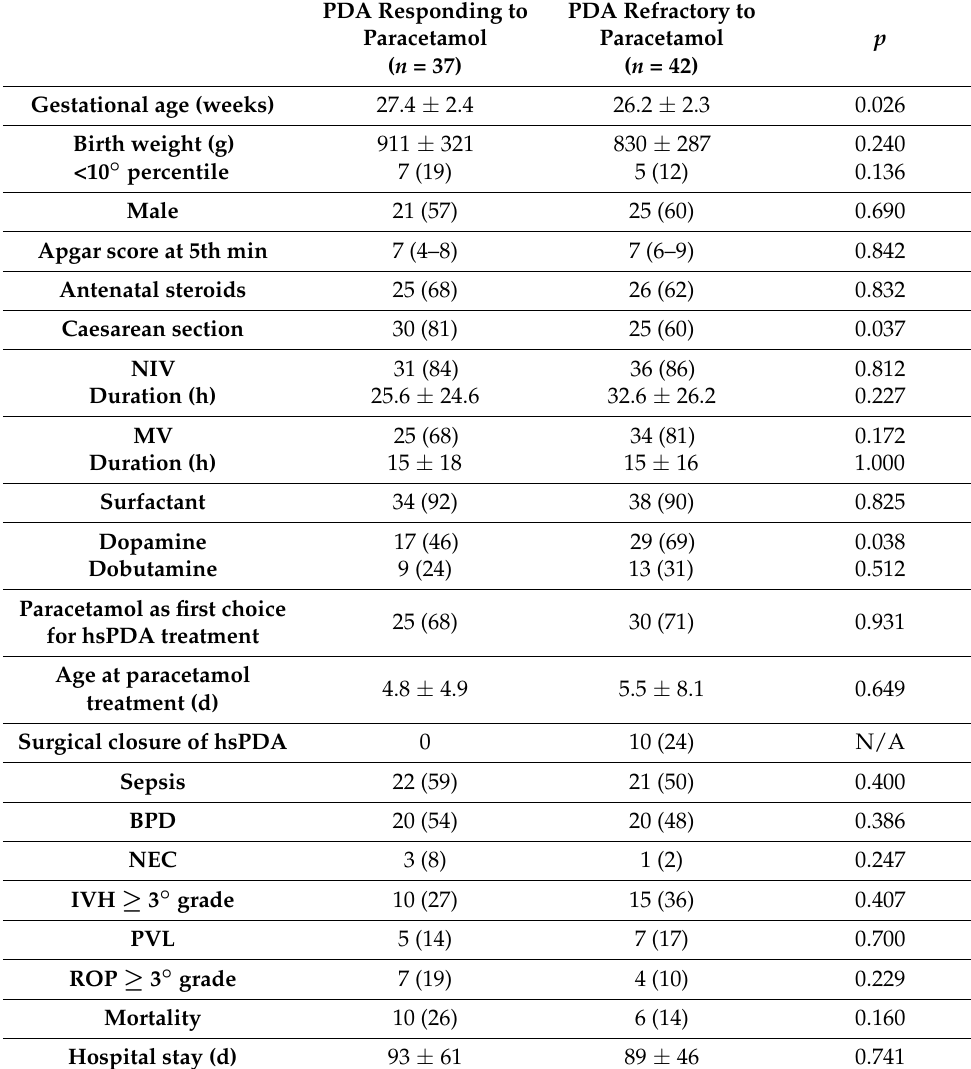
Table 1. Clinical characteristics of infants with hsPDA responding or refractory to the treatment with paracetamol. Mean ± SD or rate and (%) or median and